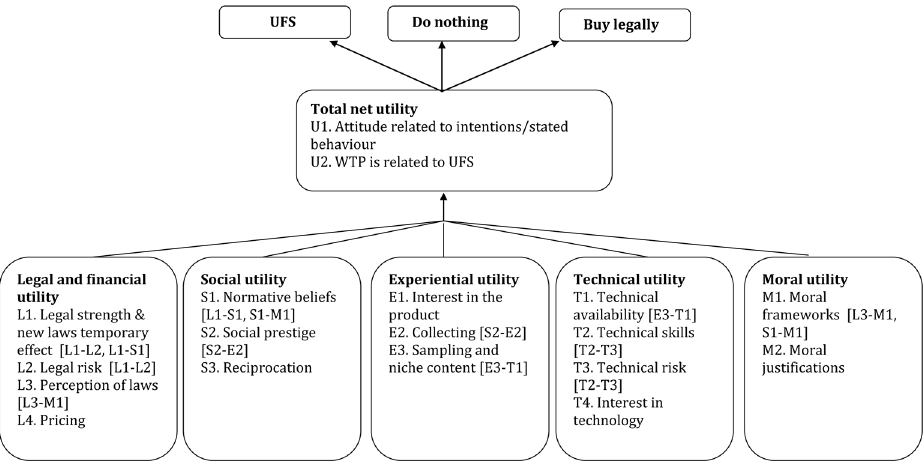
Fig 3. A conceptual framework on the decision to engage in UFS. Note: utility categories are as defined and the links between category elements (in squared brackets) are as described in Table